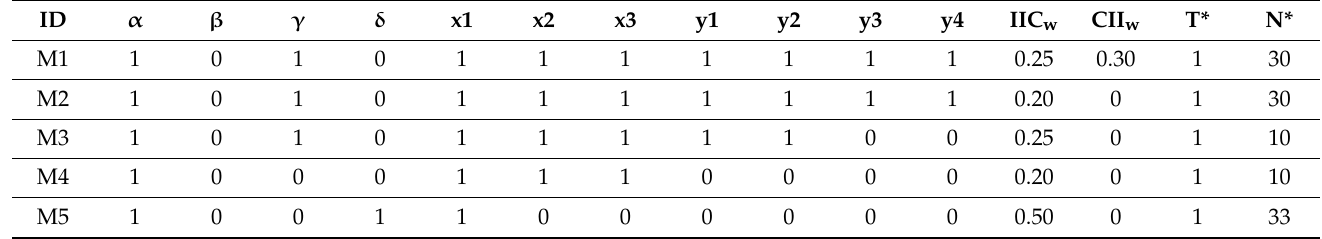
Table 5. Descriptors applied to build the models M1–M8 listed in Table 3 (+)